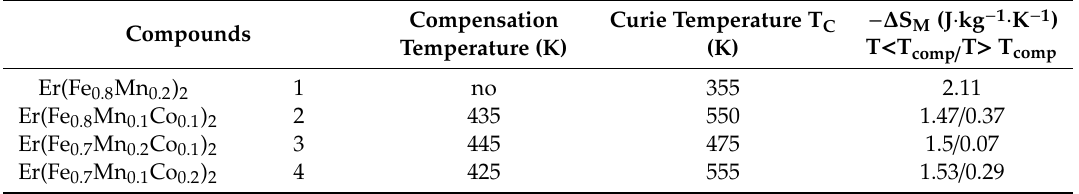
Transition temperature and maximum magnetic entropy change for Er(Fe 0.8 Mn 0.2 ) 2